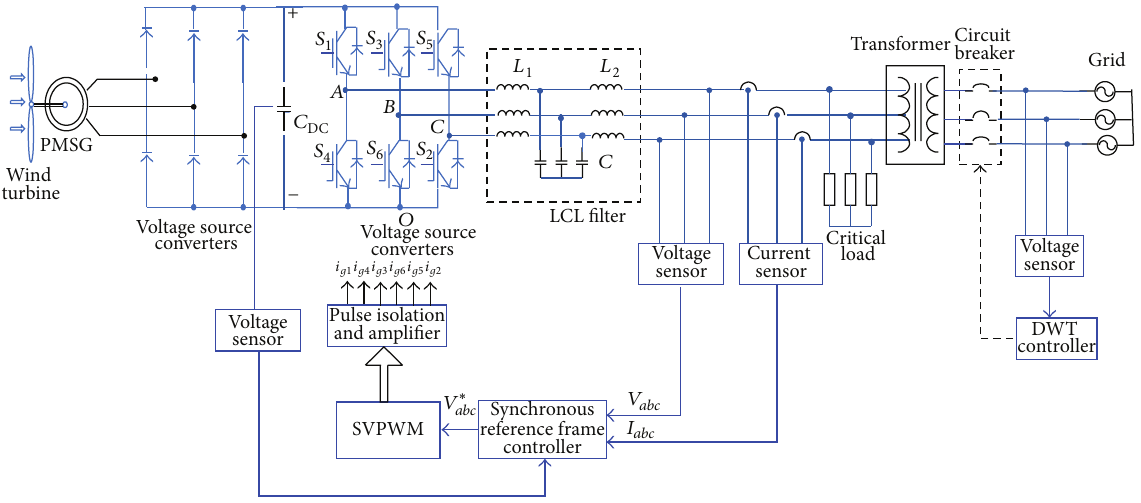
Figure 8: Schematic diagram of WECS connected to grid. Table 1: Parameters selection for proposed method.